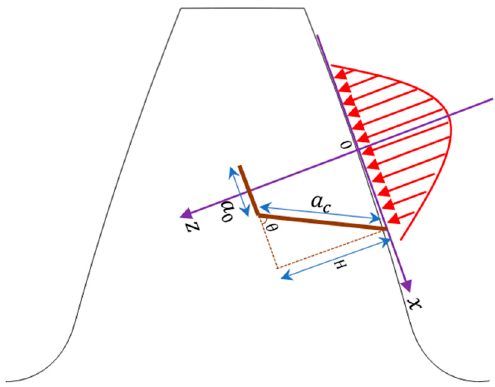
Figure 8. Crack growth diagram.